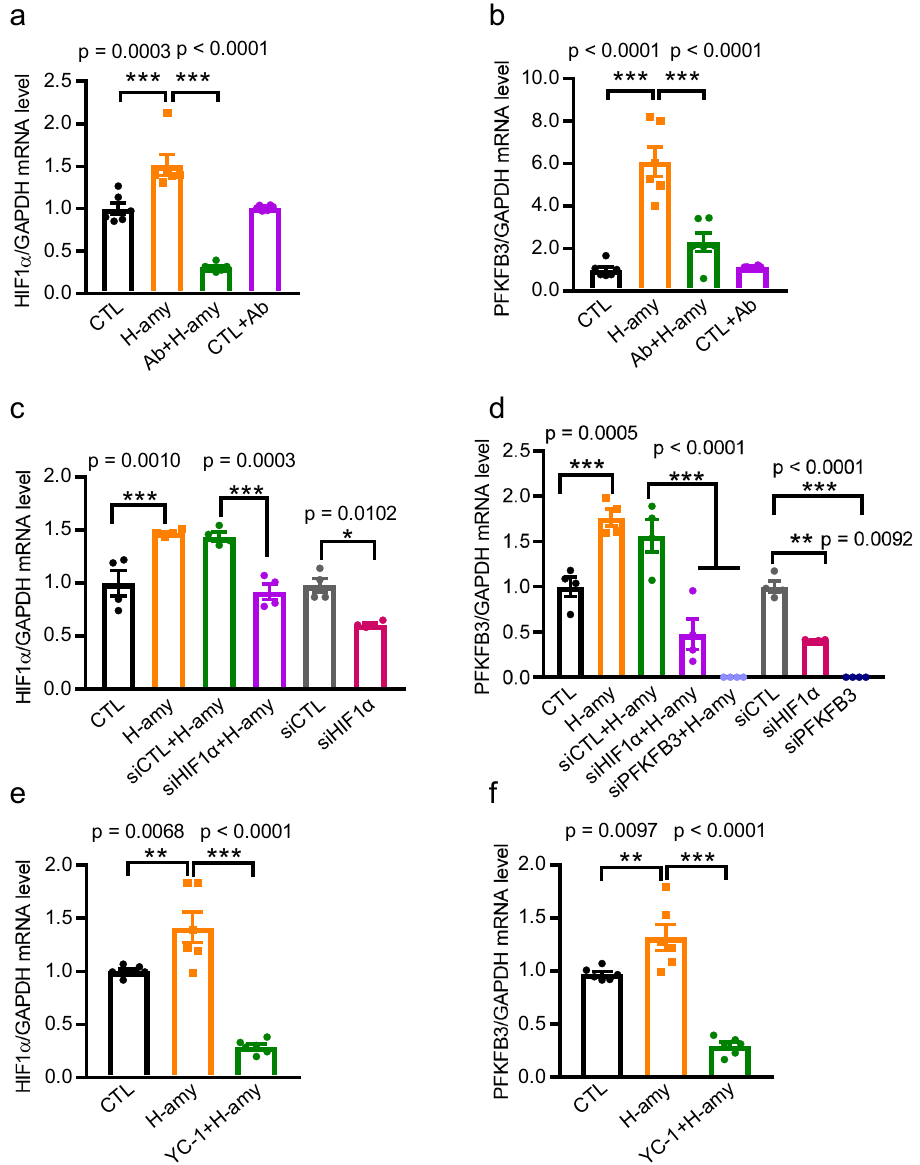
Fig. 6 Amylin drives the expression of HIF1 α and PFKFB3 in hiPSC-CMs. a , b Effect of pre-treatment of hiPSC-CMs with a human amylin antibody for 24 h on amylin-induced HIF1 α ( a ) and PFKFB3 ( b ) mRNA levels ( n = 6/group). c Effect of pre-treatment of hiPSC-CMs with siRNA for HIF1 α (siHIF1 α ) or for vehicle control (siCTL) on amylin-induced HIF1 α ( n = 4/group). d Effect of pretreatment of hiPSC-CMs with siHIF1 α , siRNA for PFKFB3 (siPFKFB3), or siCTL on amylin-induced PFKFB3 ( n = 4/group). e, f Effect of HIF1 α inhibitor YC-1 on the upregulation of HIF1 α ( e ) and PFKFB3 ( f ) induced by amylin ( n = 6/group). Data represent mean ± SEM. * P < 0.05, ** P < 0.01, *** P < 0.001 by One-way ANOVA with Tukey ’ s